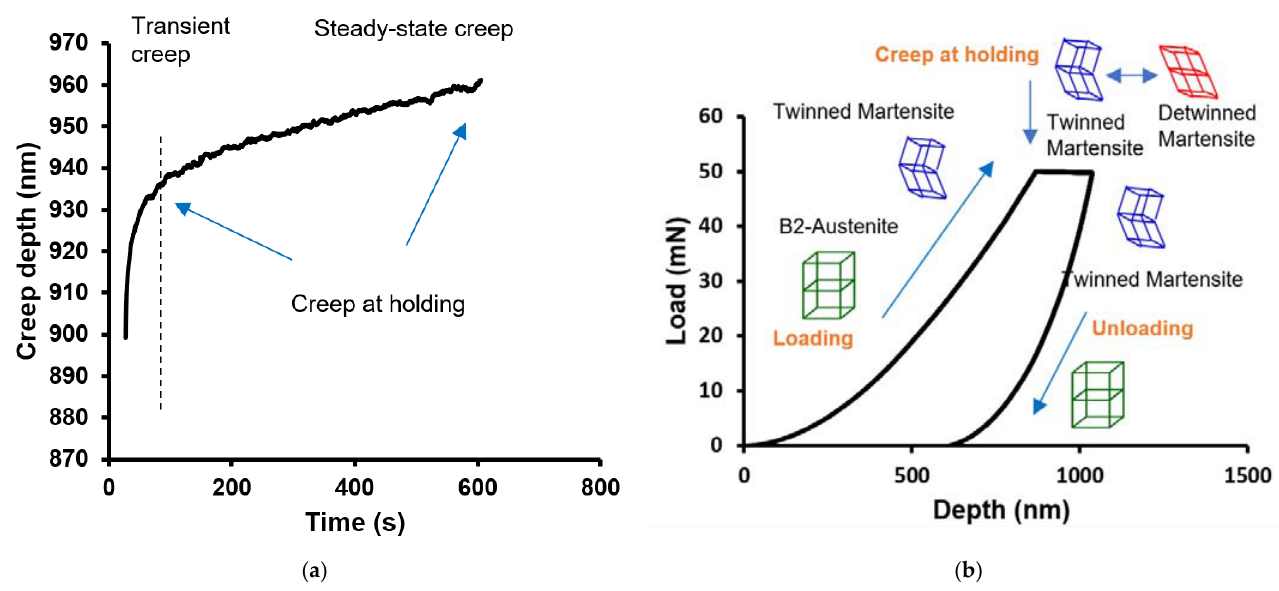
Figure 1. ( a ) Indentation creep curve showing the stages of creep; ( b ) schematic of the testing procedure for constant load–hold method indentation creep test [27].